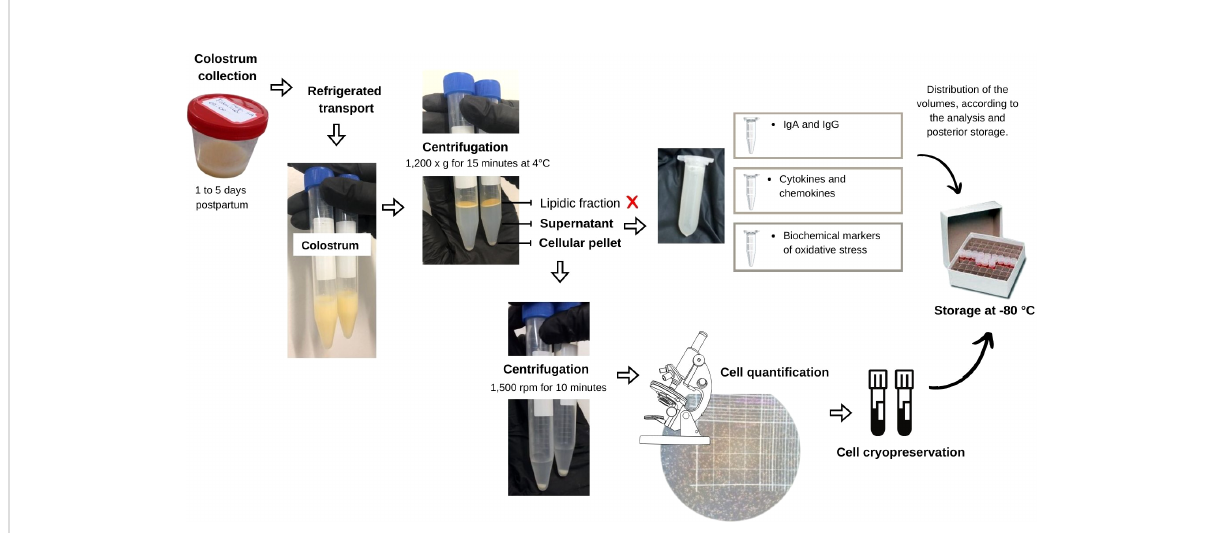
FIGURE 1 Flowchart representing the step of collection and preparation of colostrum for